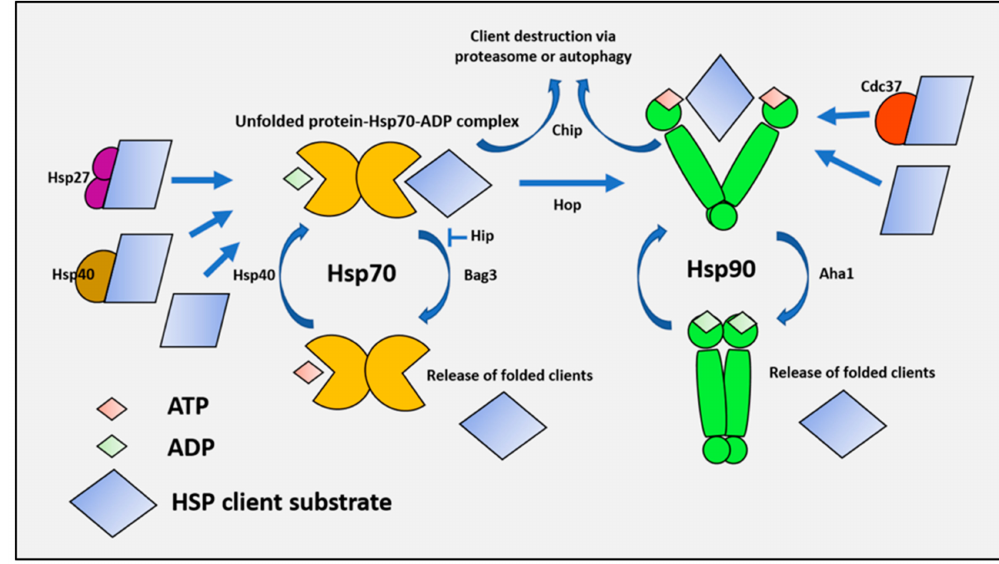
Figure 2. Integrated Hsp27, Hsp70, and Hsp90 functions promote proteostasis. There are multiple entry points into the cytosolic chaperone network, where substrates can be recruited by Hsp27, Hsp70 co chaperones (e.g., Hsp40 family members), and Hsp90 co chaperones (e.g., Cdc37), or are bound directly by Hsp70 or Hsp90. Unfolded client proteins are relayed from Hsp27 or Hsp40 to the ATP-bound Hsp70 complex under the direction of J domain co-chaperone DNAJ. Binding of the unfolded client triggers the innate ATPase activity of Hsp70 through allosteric interactions, leading to a high a ffi nity complex containing Hsp70, client, and ADP. The complex then undergoes nucleotide exchange facilitated by binding the co-chaperone Bag3. ADP is exchanged for ATP, which lowers the a ffi nity of Hsp70 for the bound client that is released. Alternative destinations for Hsp70 substrates include proteasomal degradation via STUB1 / CHIP, or transfer via HOP for further folding by the Hsp90